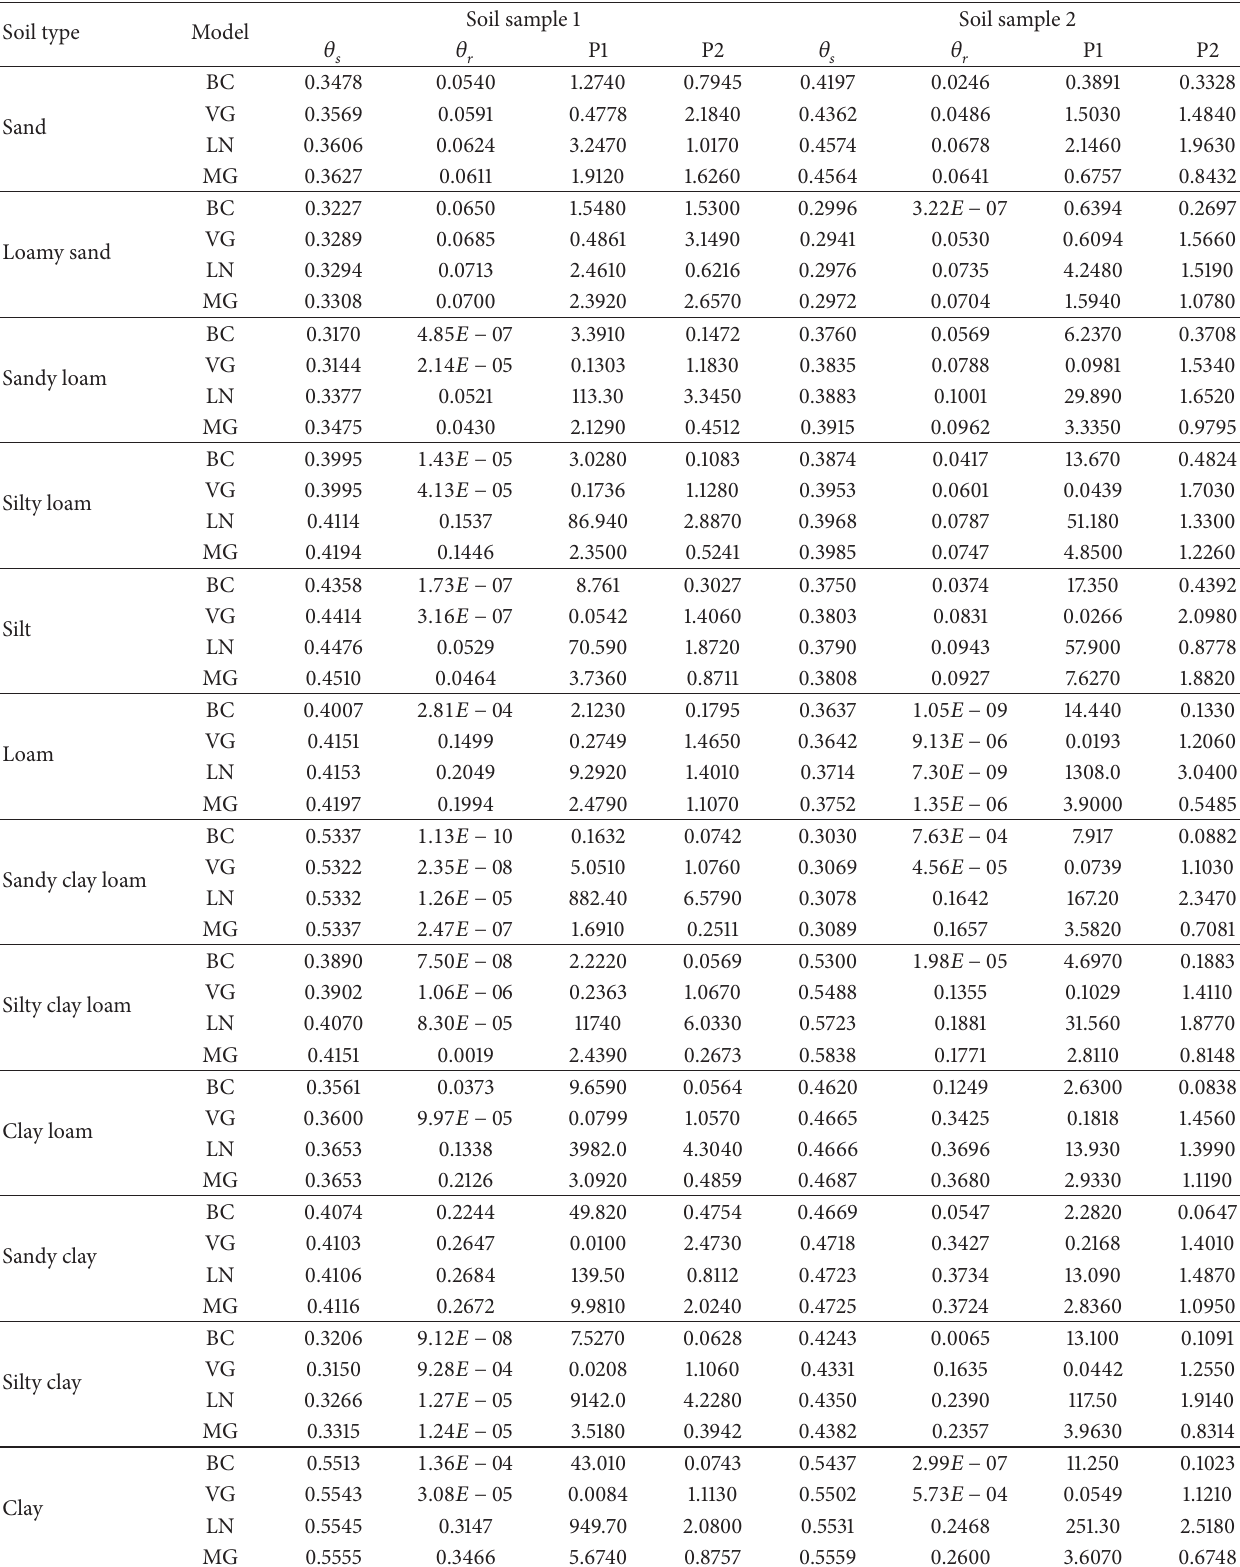
Table 3: Model parameter values for various soil textural